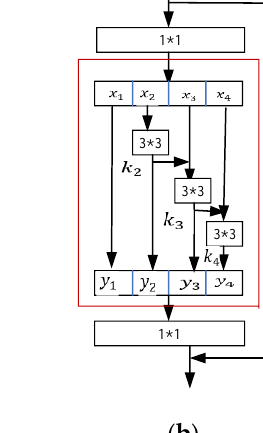
Figure 4. ResNet and Res2net network infrastructure diagram. ( a ) ResNet infrastructure diagram; ( b ) Res2Net infrastructure diagram.